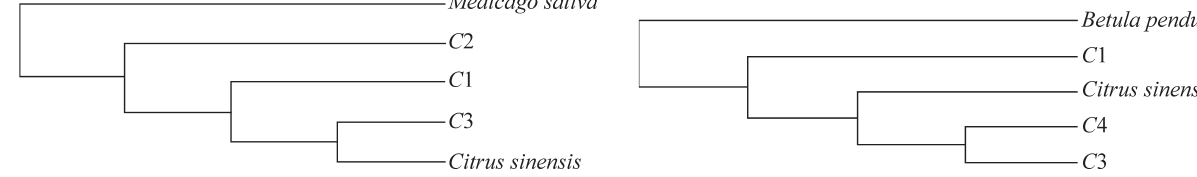
Figure 4 - Cladogram showing phylogeny relation among contigs 1, 2 and 3withcinnamicacid4-hydroxylasefrom Citrussinensis (AAF66066)and Medicago sativa (gi|166372).